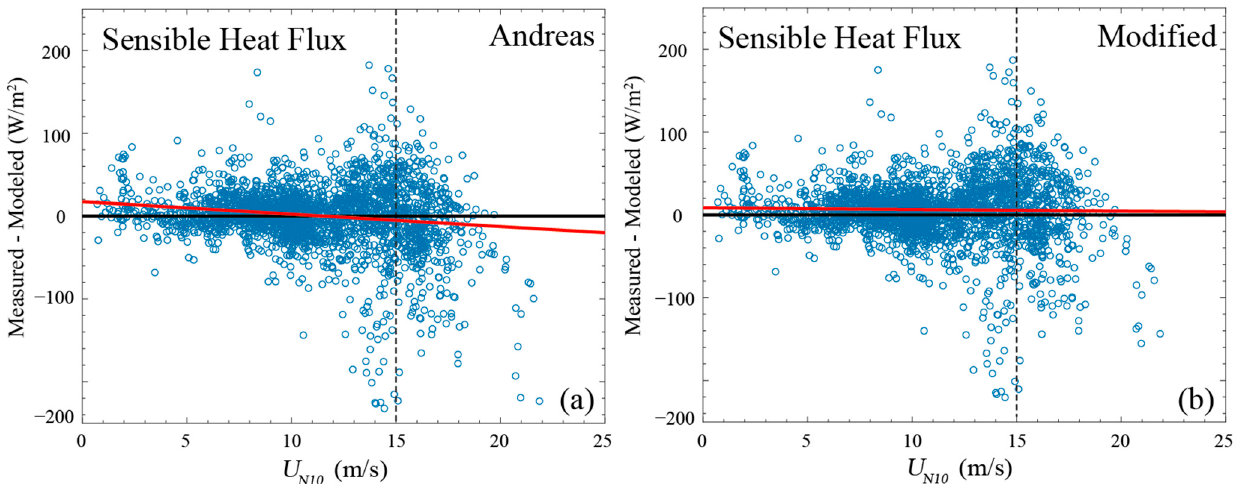
Figure 5. Comparison of the performance of the original and modified algorithms in the simulation of air–sea sensible heat flux. Other settings are the same as in Figure 4. ( a ) reflects the difference between the measurements and the modeled heat flux, including the sea spray-induced heat flux calculated by the AN15 algorithm; ( b ) also reflects the difference between the measurements and modeled results, but, here, the sea spray-induced heat fluxes are calculated by the modified algo- rithm.